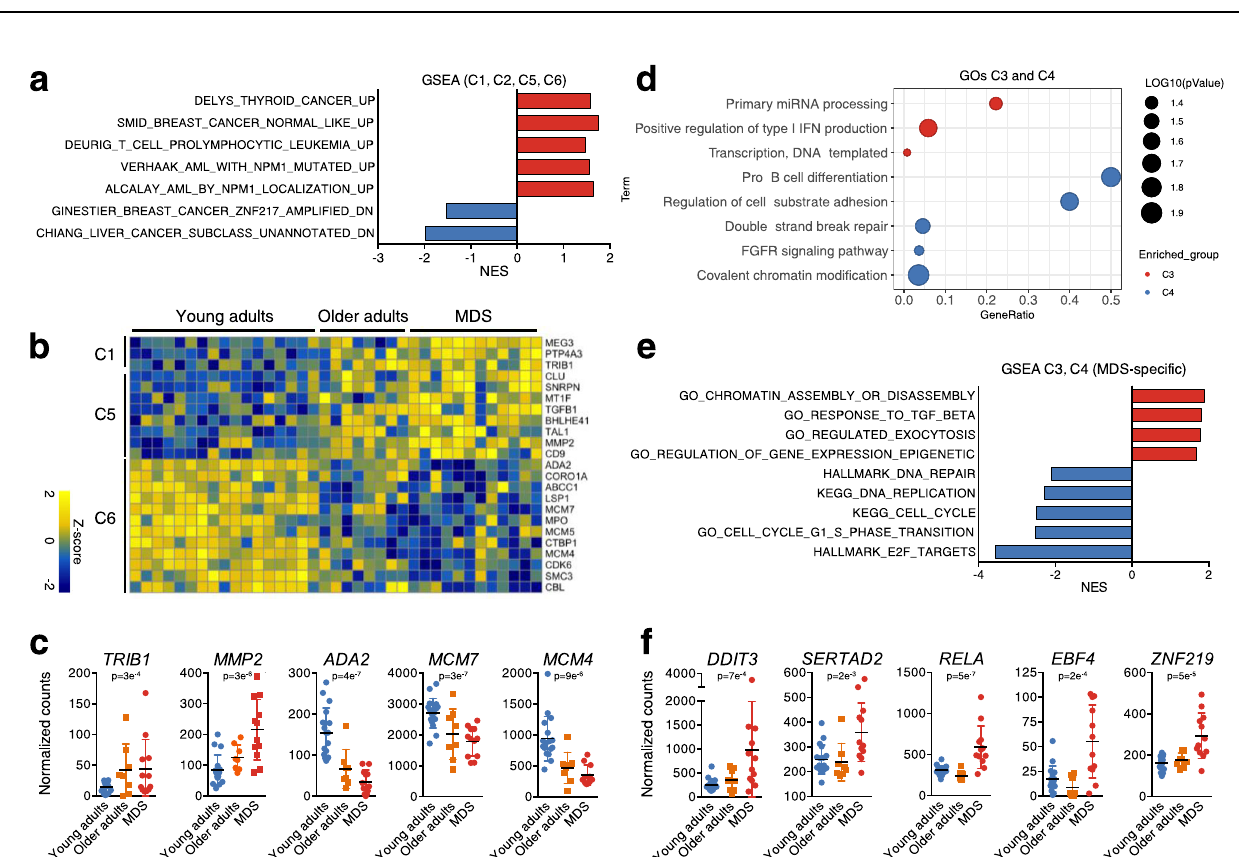
Fig. 1 | Altered transcriptional pro fi les of HSCs in aging and MDS. a Schematic representation of lesions taking place in aging and in MDS. Aging is characterized bytranscriptionallesionsofHSCsandcanalsopresentmutationsinspeci fi cgenes. MDS HSCs usually present genetic lesions but the transcriptional pro fi le of these cells remains unexplored. Part of this fi gure was made in ©BioRender - bior- ender.com. b Schematic representation of the experimental approach: bone mar- row specimens from young and older healthy adults as well as from MDS patients were obtained,and HSCs (CD34 + CD38 - CD90 + CD45RA - )wereisolated using FACS. The transcriptome of these cells was characterized using MARS-seq. Part of this fi gure was made in ©BioRender - biorender.com. c Principal component analysis (PCA) of the transcriptome of cells isolated in B. Healthy young (blue), older (yel- low) adults, and MDS cells (red) are plotted. The percentage of variance explained by PC1 and PC2 principal component is indicated in each axis. d Venn diagram representingapartialoverlapofgenesderegulatedinaging(youngvsolderhealthy adults),inthetransitiontothedisease(healthyolderadultsvsMDS)orbetweenthe more distant states (healthy young vs MDS). The number of common or exclusive DEGs is indicated in each area. e Bar-plot showing enriched biological processes